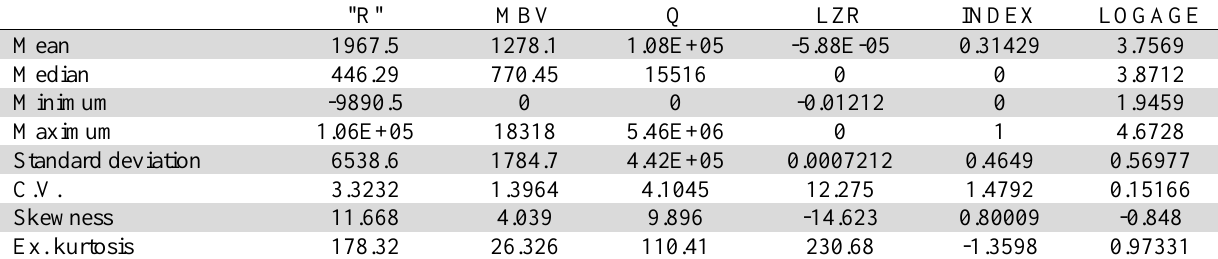
The summary of some basic statistics